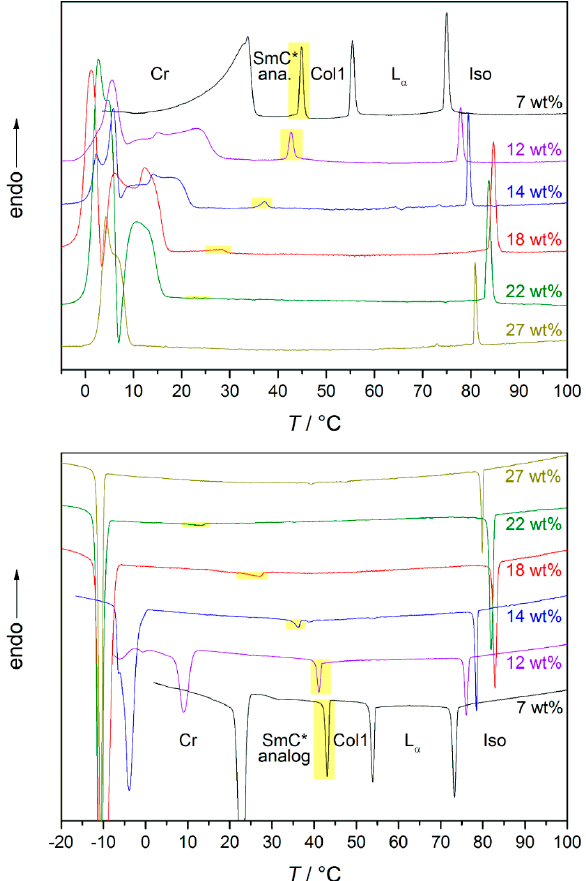
Figure 20. DSC curves obtained while heating (top) and cooling (bottom) the system 4 / formamide. The weight fraction of formamide is indicated in the graphs. The transition from the high temperature phase to the lyotropic SmC* phase is highlighted in yellow. In the sample with the smallest amount of formamide the high temperature phase is a columnar (Col1) phase. For the samples with 12 to 22 wt% of formamide, it is a L α phase. In case of the sample with the highest formamide concentration, the only mesophase occurring is a L α phase (cf. Figure 15). (Reprinted by permission from Springer Nature: [13].)